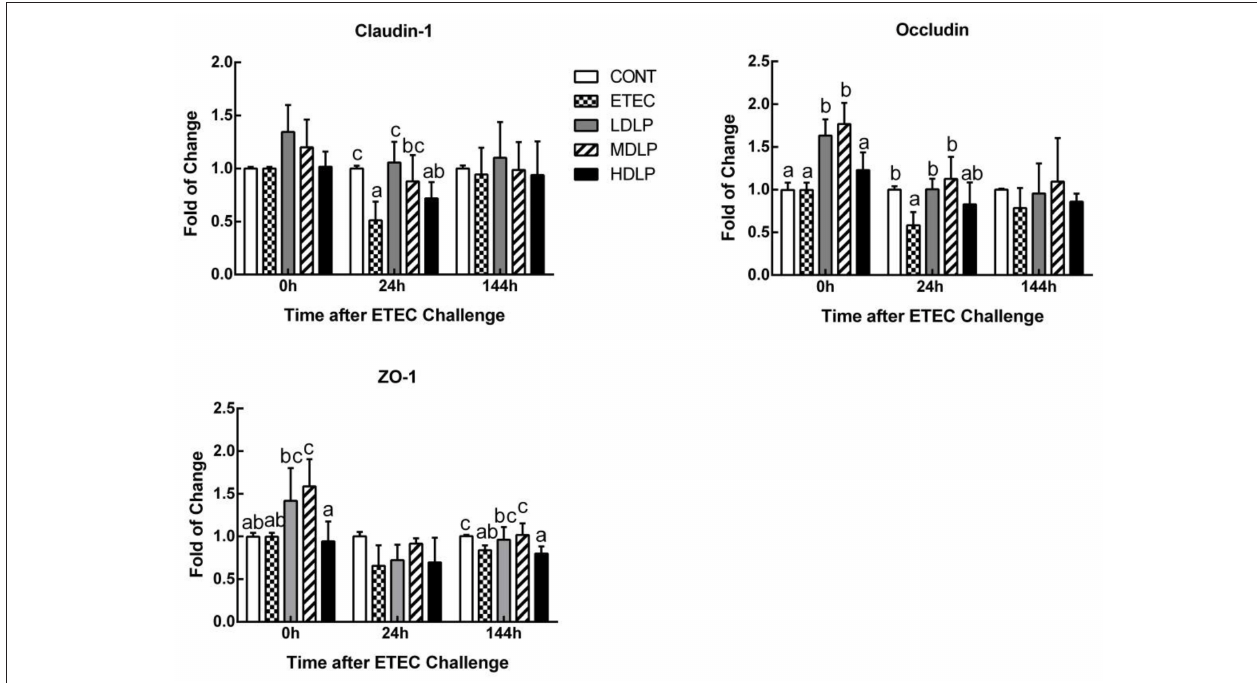
FIGURE 5 | Dose effect of Lactobacillus plantarum on tight junction proteins mRNA expression in jejunum of mice during pre- and post-challenge periods. CONT, control group, treatment with PBS at all period; ETEC, negative group, oral challenge with ETEC on day 15; LDLP, low dose (5.0 × 10 8 cfu mL − 1 ) group; MDLP, intermediate dose (5.0 × 10 9 cfu mL − 1 ) group; HDLP, high dose (5.0 × 10 10 cfu mL − 1 ) group; LDLP, MDLP, and HDLP groups were infected with ETEC at day 15. Bars with different letters are significantly different ( P < 0.05). Bars share the same letters do not differ significantly ( P >